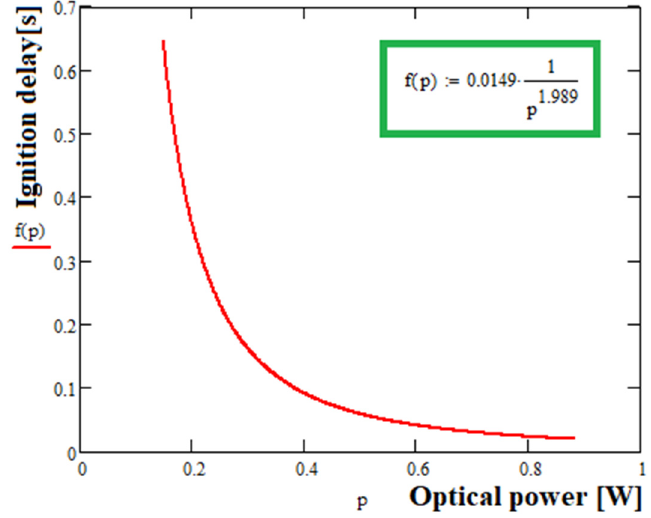
Figure 2. Optical ignition delay times and safe boundary curve with a safety factor of 2 [3].